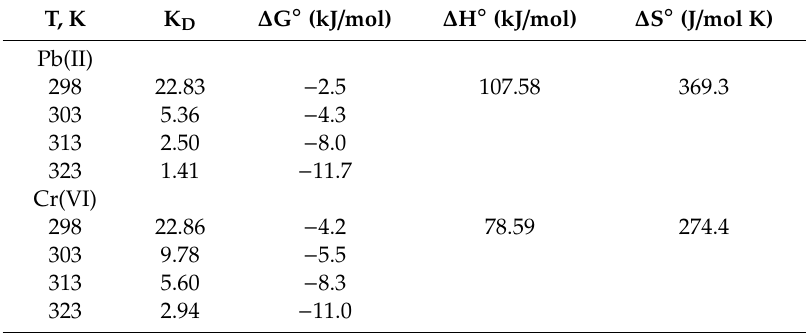
Table 2. Thermodynamic parameters of the biosorption of Pb (II) and Cr (VI) ions onto